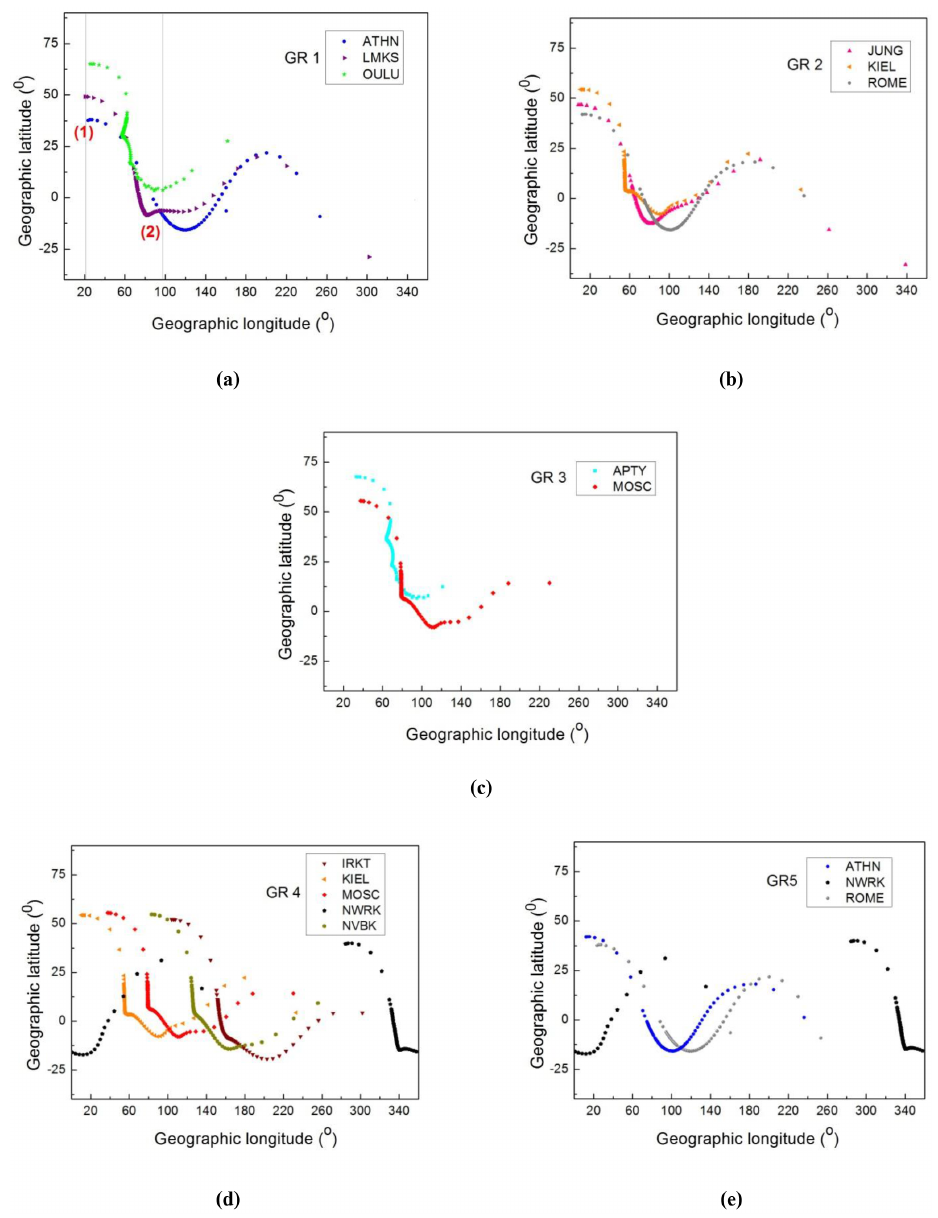
Figure 3. Asymptotic directions of viewing for all the groups of the NM stations GR 1, GR 2, GR 3, GR 4, and GR 5 obtained by the Tsyganenko96 model corresponding to the quiet geomagnetic period of 1 January